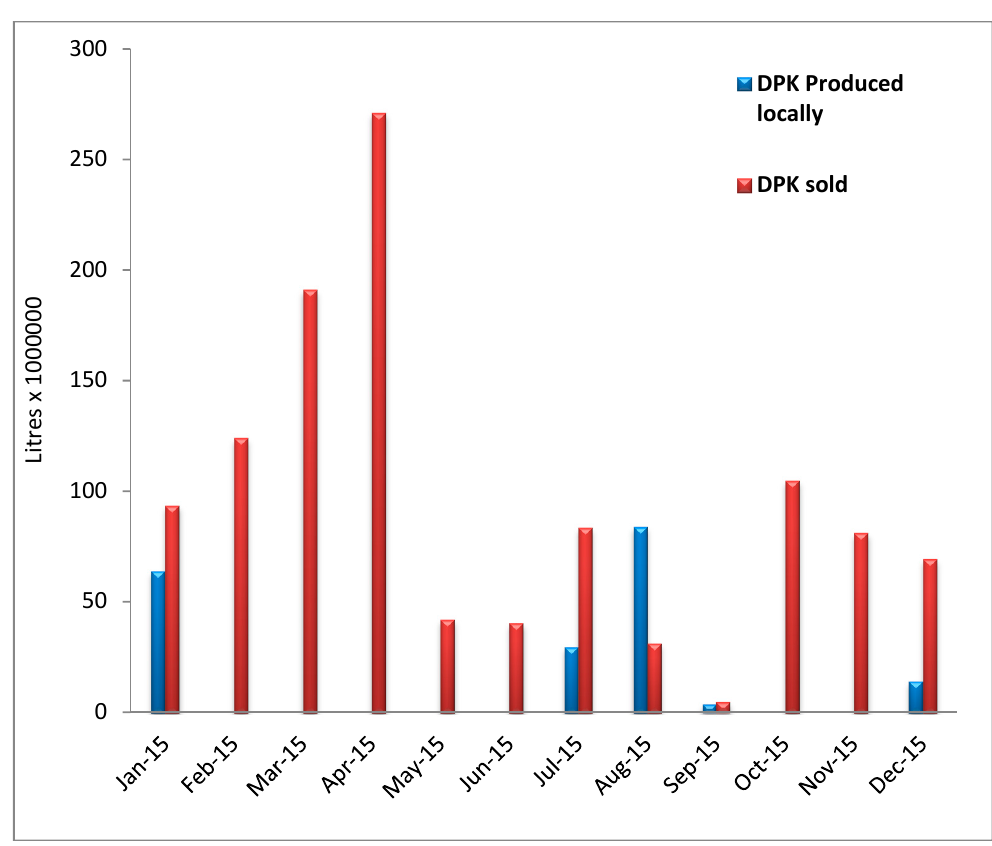
Figure 6. Comparison of DPK produced locally and DPK sold in 2015. Data adapted from NNPC January 2016 Financial and Operation Report [55]. DPK: Demand for dual-purpose kerosene.